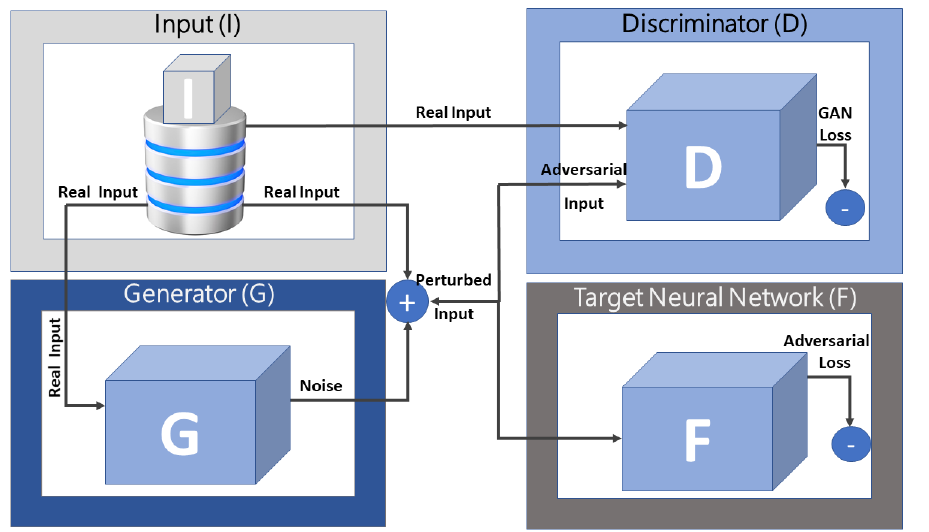
Figure 5. AdvGAN Architecture (Recreated with permission from [32]. Original is copyrighted with the International Joint Conferences on Artificial Intelligence (IJCAI), 2018. All rights